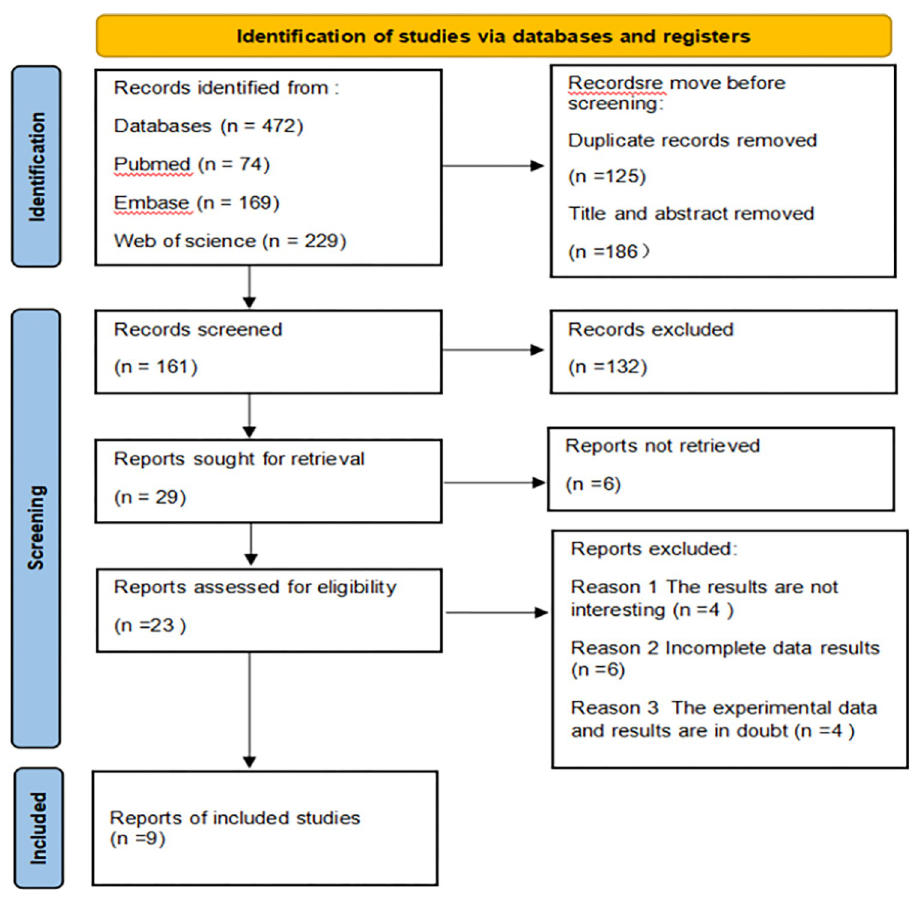
Fig 1. Flow chart of literature